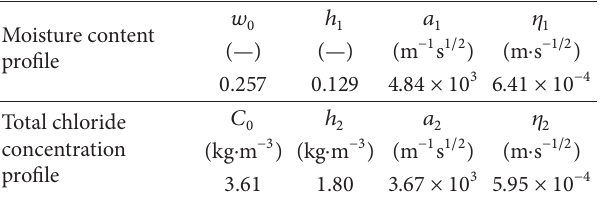
Table 1: The best-fit values of the profiles’ parameters for the erfc approximations. The model profile fits are in good agreement with thedata:thecoefficientofdeterminationandrootmeansquareerror are 𝑅 2 = 0.9972 and RMSE = 8.64×10 −3 for the moisture profile and 𝑅 2 = 0.9949 and RMSE = 0.152 kg ⋅ m −3 for the concentration profile